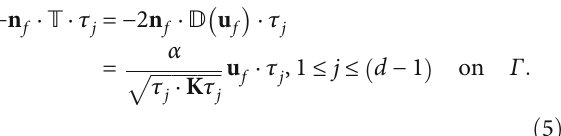
Figure 1: Global domain Ω consisting of the fl uid region Ω porous media region Ω